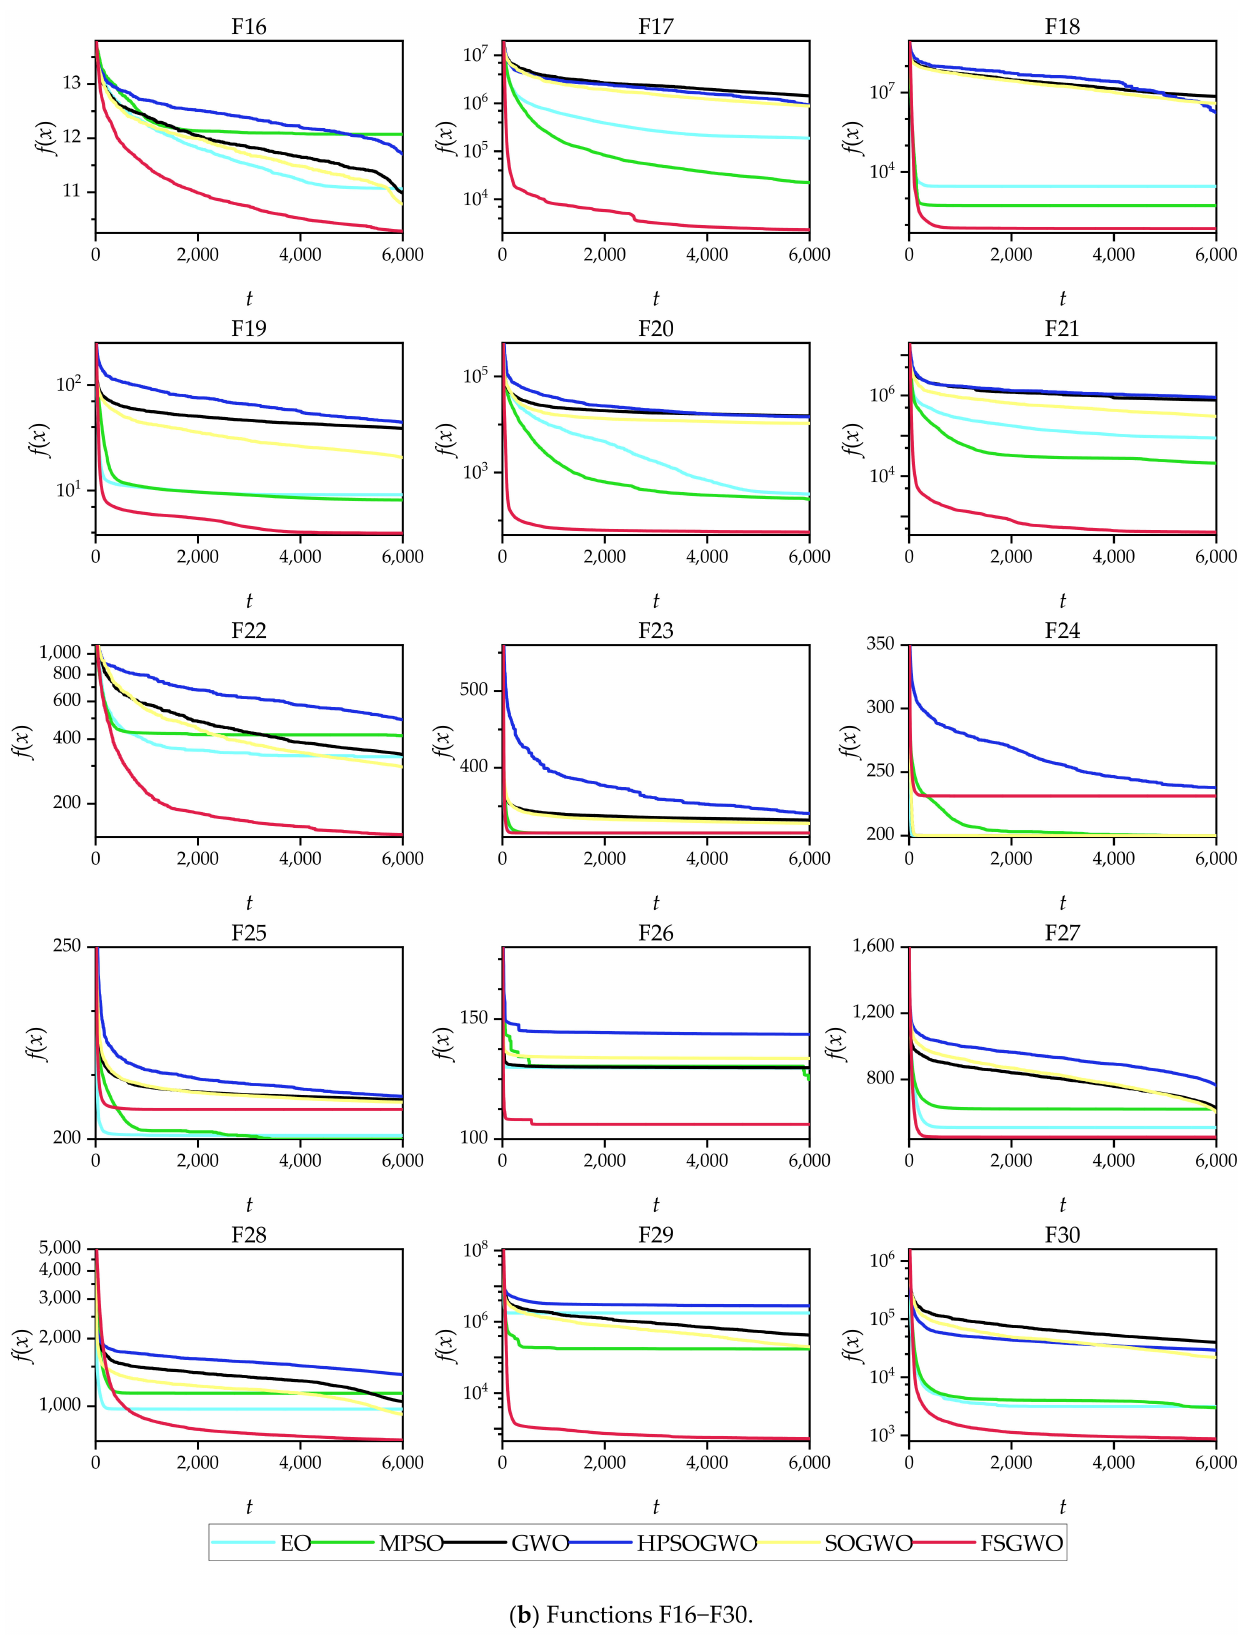
Figure 3. Convergence curves of the related algorithms for the 30-dimensional